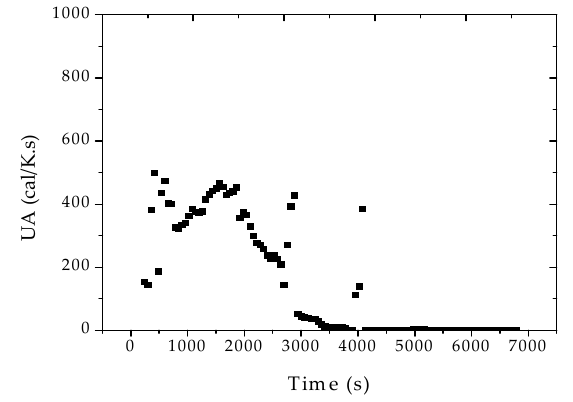
Processes 2017 , 5 , 51 Figure 8. Reconciled UA profiles for reaction R1, considering the formation of fresh monomer droplets.